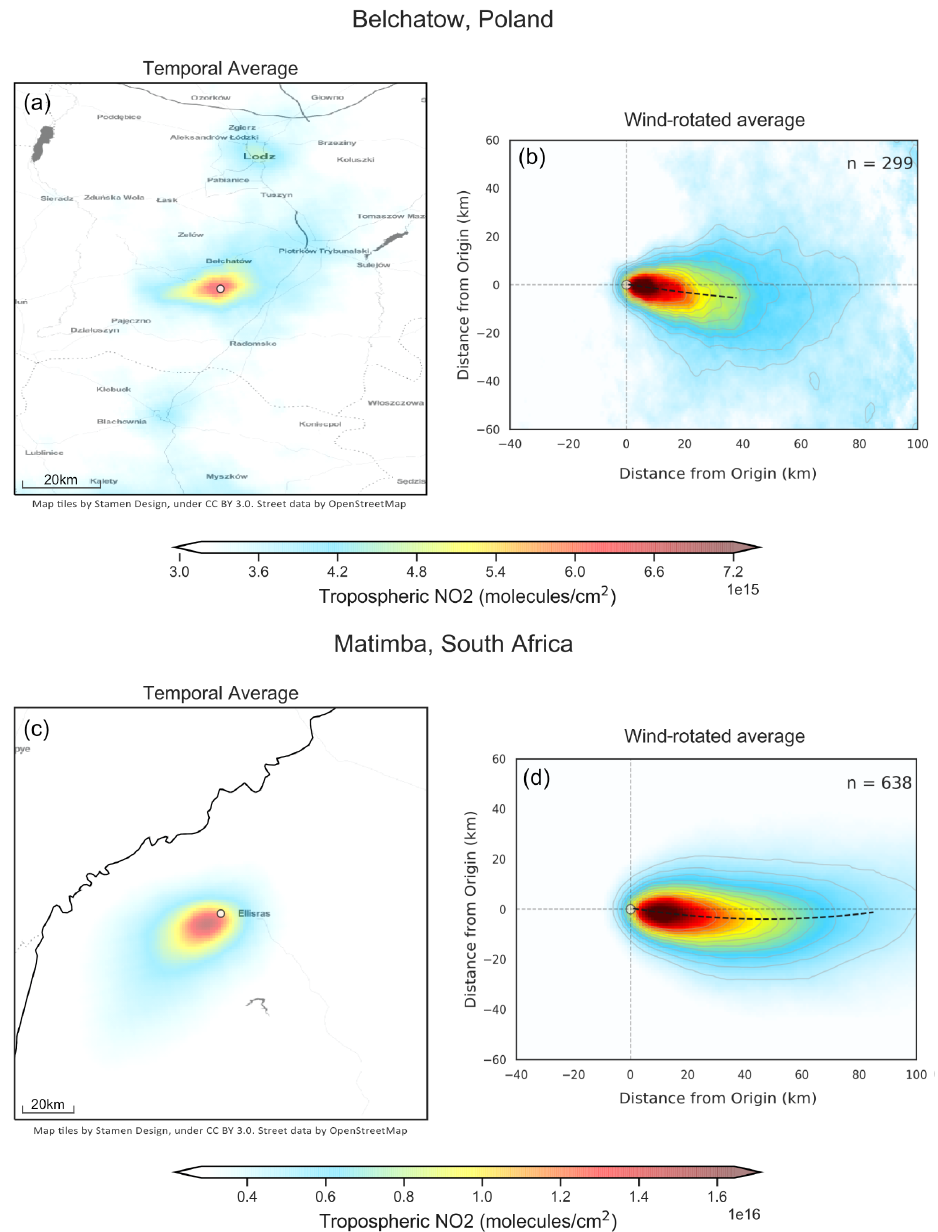
Figure 8. Unrotated and wind-rotated average tropospheric NO 2 columns from TROPOMI, using data from May 2018 to December 2021, for (a–b) Belchatow power station in Poland and (c–d) Matimba power station in South Africa. Map tiles were created by Stamen Design (CC BY 3.0). Street data were obtained from OpenStreetMap